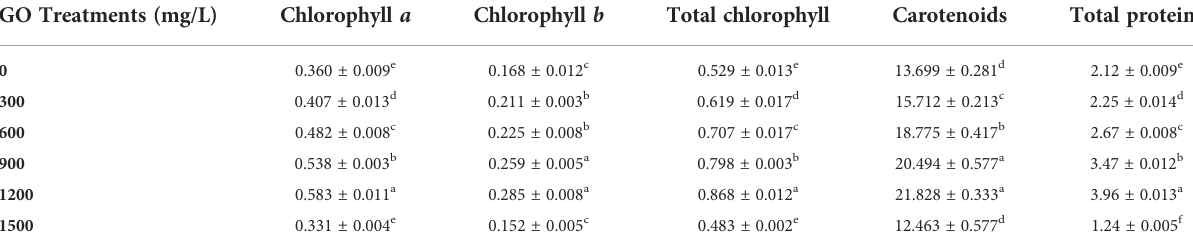
Data represent the mean ± standard error. Different letters denote statistically signi fi cant differences between treatments as evaluated by the Tukey ’ s Multiple range test at the P<0.05 level. C= without GO NPs application (control; T1= 300 mg/L; T2= 600 mg/L; T3= 900 mg/L; T4= 1200 mg/L; T5= 1500